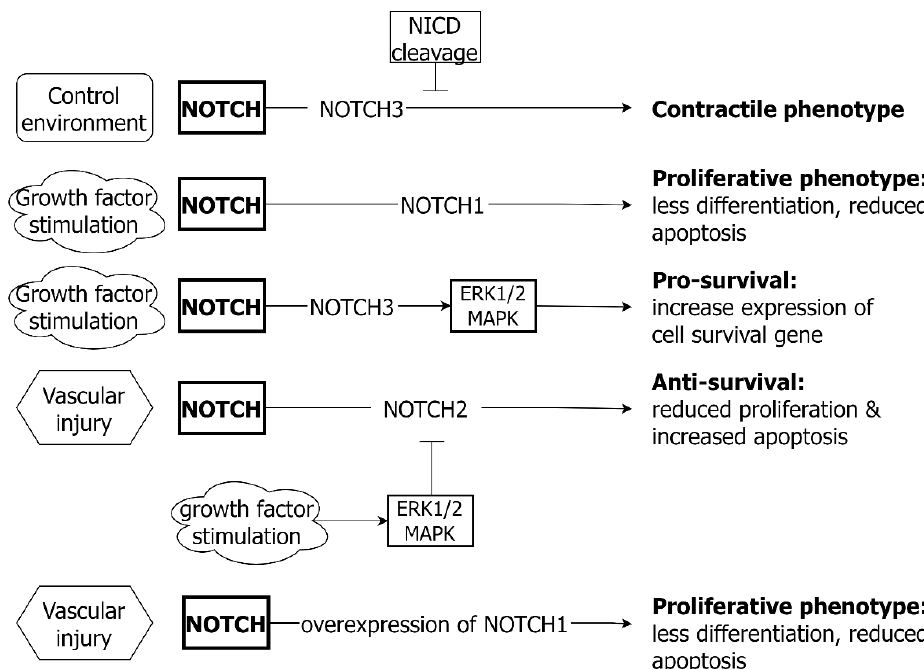
Figure 7. Summary of the mechanisms of NOTCH signaling pathways in VSMC. While NOTCH3 signaling promotes the contractile phenotype, stimulation of other NOTCH isoforms results in pro- liferative signaling and either cell survival or apoptosis depending on the circumstances.